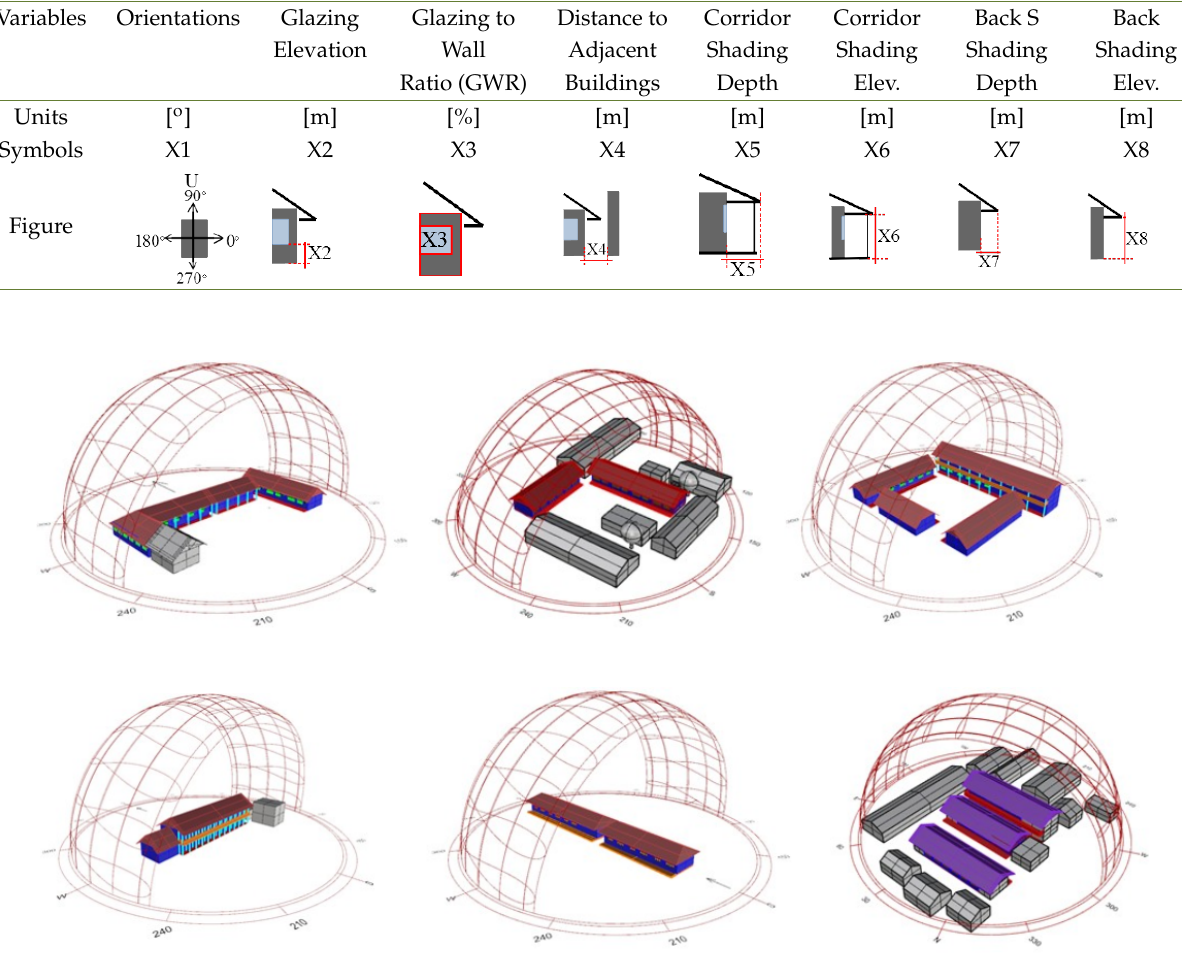
Fig. 1. Some digital modelling representation, for school objects in Rhinoceros with additional sun paths were added using Ladybug